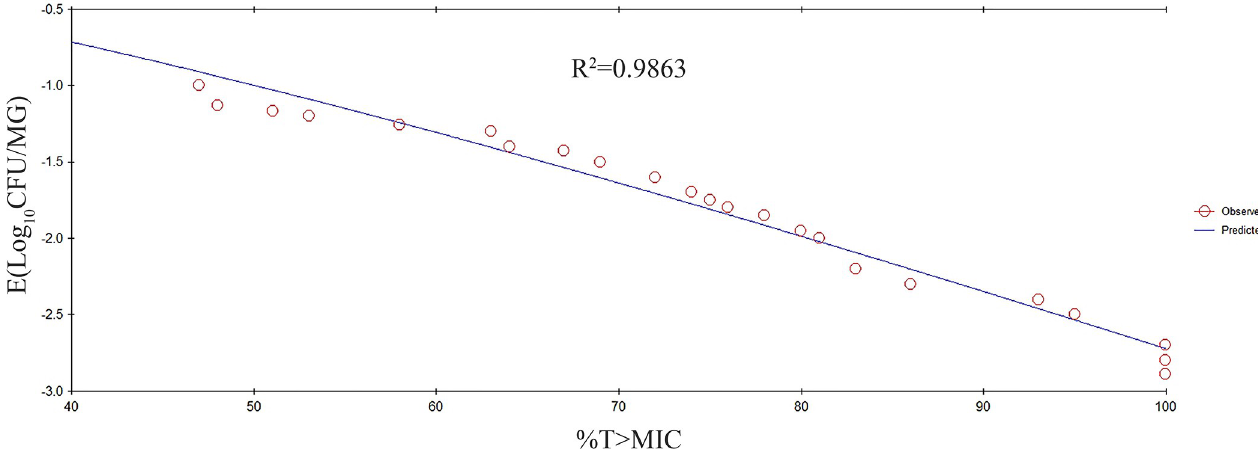
Fig 5. The inhibitory Sigmoid E max relationship between in vivo antibacterial effects ( 4 log CFU/MG) and PK/PD index of %T > MIC against S . agalactiae 3–64. The line represents the fit of the model to the data. The circles represent the observed PD data. R 2 indicates the correlation coefficient.